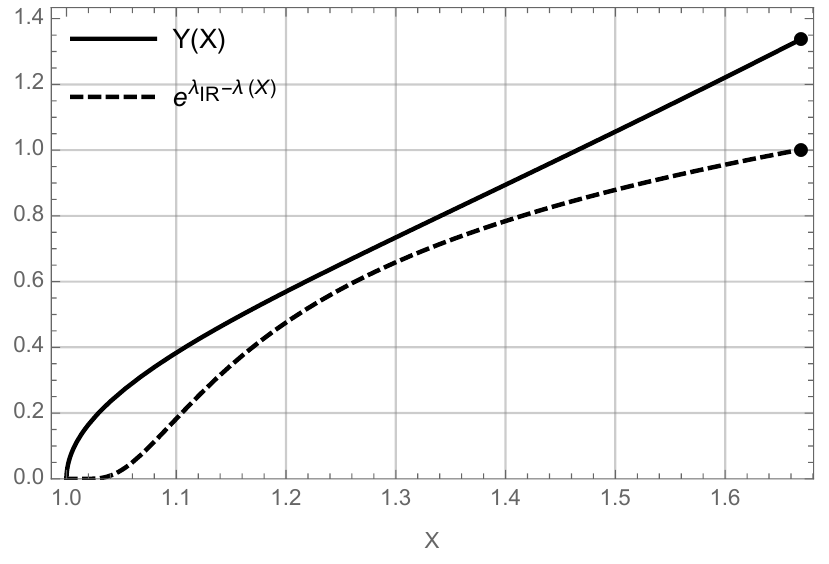
Figure 2 . A numerical solution for the functions Y ( X ) and (cid:21) ( X ) in the case p = 5. Notice that since (5.24) is quadratic in Y , the function (cid:0) Y is also a solution with (cid:21) unchanged. The far UV region is at Y = 0, X = 1 and the IR region where the S 6 smoothly caps of is indicated by the solid